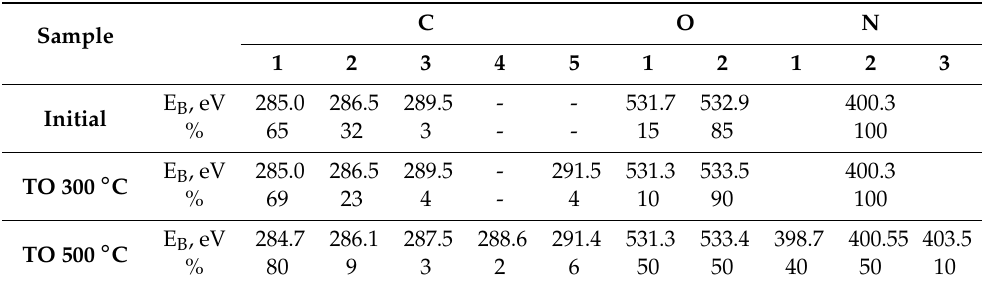
Table 2. Binding energies (E B ) obtained from the high resolution spectra of the initial and modified carbon fibers [43].